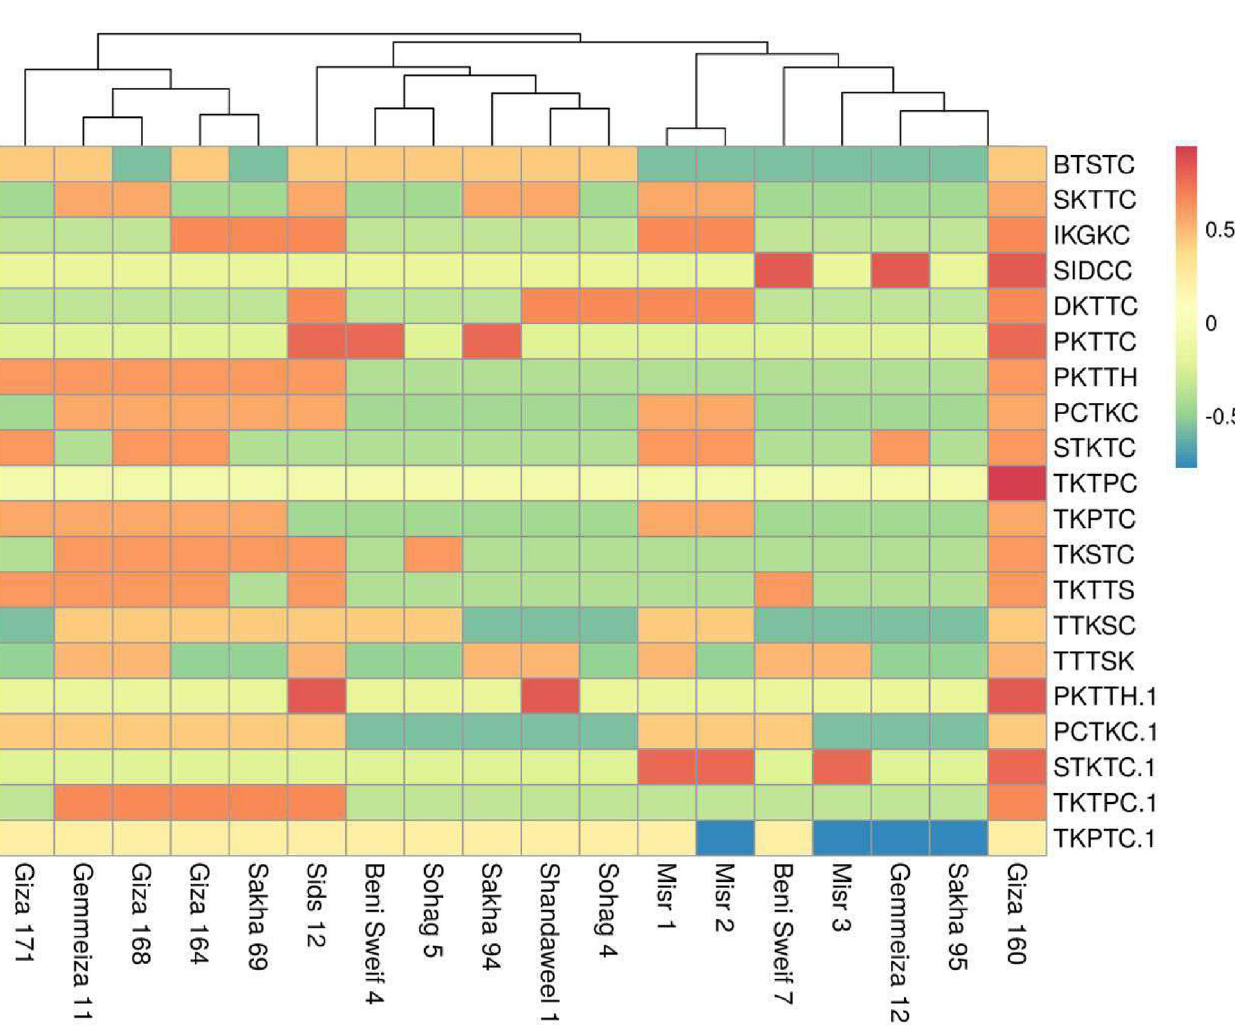
Fig 1. One-dimensional heat map showing the clustering of the 18 wheat varieties based on the presence of rust strains and varieties’ performance revealed grouping into three distinct groups. Rows represent the 18 wheat genotypes and columns represent the 20 rust